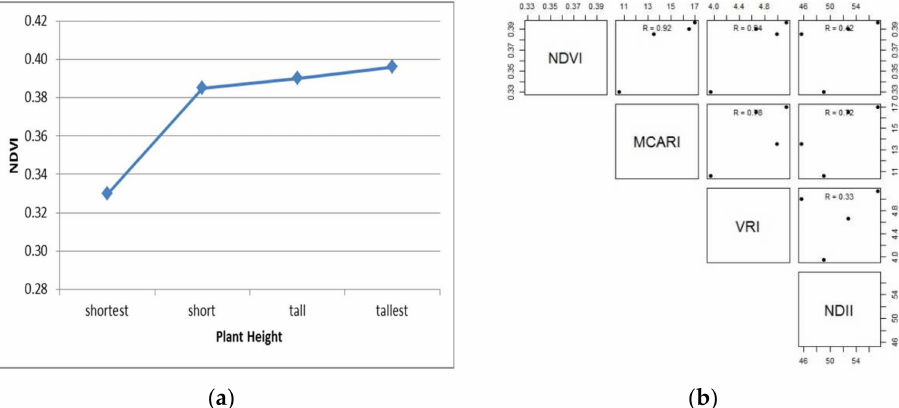
respectively (Table 5). The increasing NDVI values indicate the plant’s excellent physical growth, development, and healthy condition. This is further indicated by the greenness level of the NDVI, which also represents the highest chlorophyll content of each plant (leaves) (Figure 11a). The MCARI spectrometer estimated the chlorophyll content of each plant, also showing an increasing range from 10.54–17.02 g. The relationship between NDVI values and the MCARI spectrometer is strongly positive (R 2 = 0.92) (Figure 11a). NDVI also shows a strongly positive relationship with the VRI spectrometer (R 2 = 0.94), and a medium positive relationship with the NDII spectrometer (R 2 = 0.42) (Figure 11b).